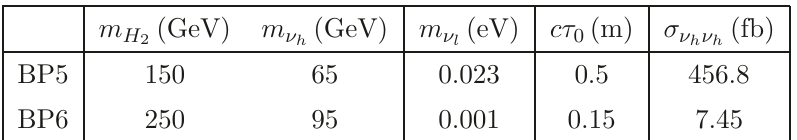
Table 2. Definition of the BPs leading to DVs from the heavy neutrinos produced from the heavy Higgs. From left to right, the columns display the values of heavy Higgs mass, heavy neutrino mass, light neutrino mass, heavy neutrino proper decay length and heavy neutrino pair production